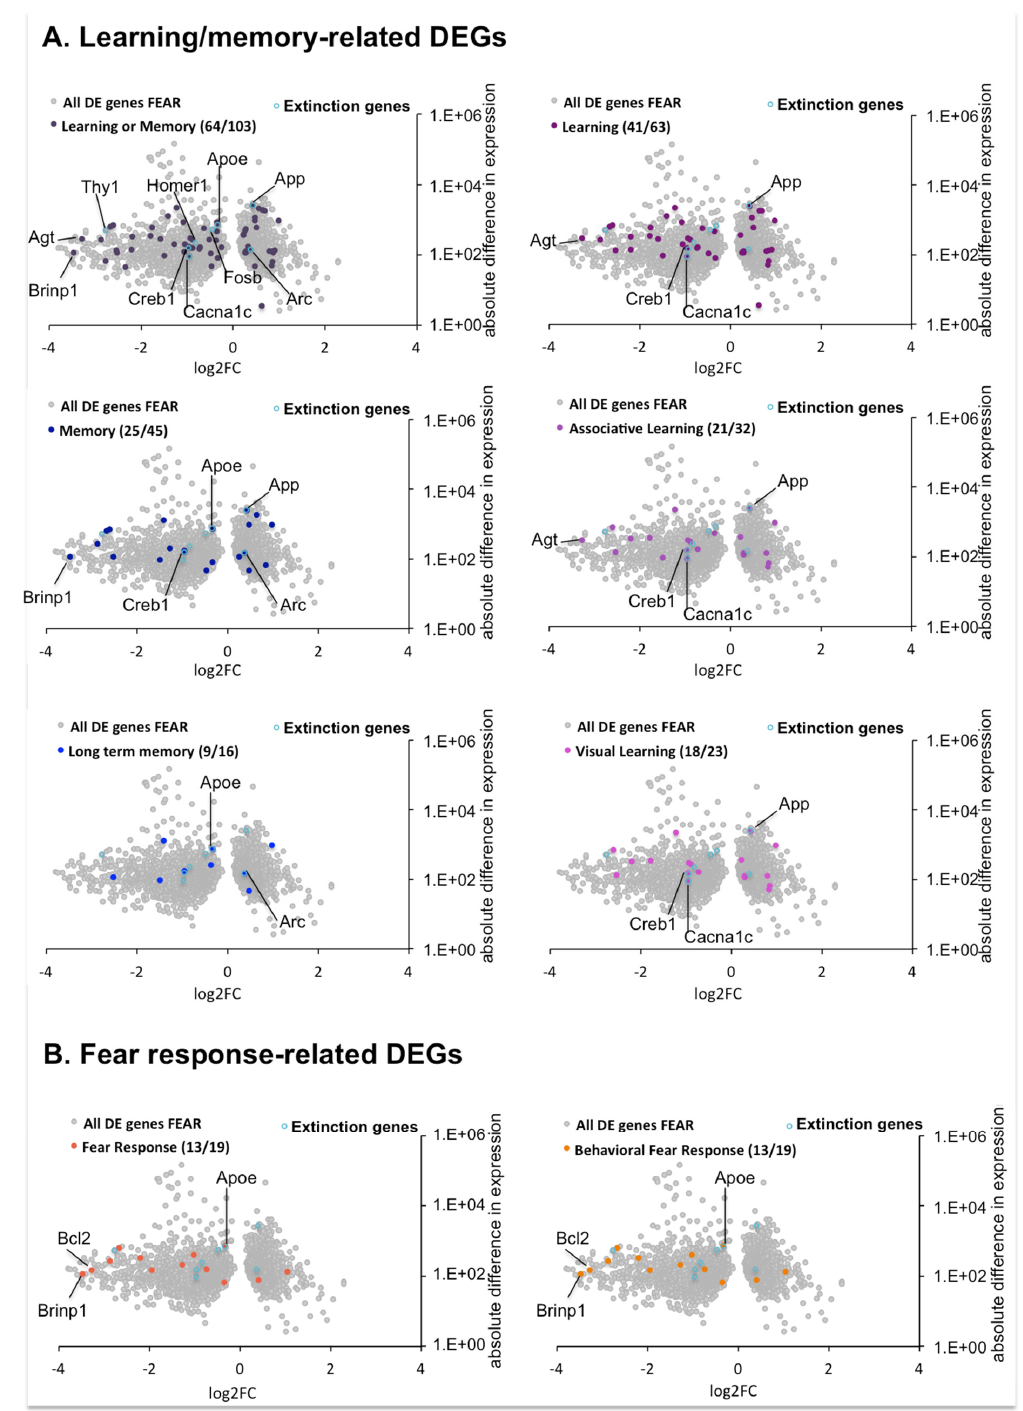
Figure 7. Differentially Expressed Genes (DEGs) with Gene Ontology annotations associated to Learning/memory and Fear response, between OPTO FEAR vs. SHAM FEAR groups. DEGs for each indicated Biological Process (BP) are highlighted as colored dots on the volcano plot representing the total DEGs between OPTO FEAR vs. SHAM FEAR groups, indicated by grey dots. Numbers into brackets indicate the number of DEGs related to each indicated BP over the gene universe. Light blue dots indicate genes described in literature as associated to fear extinction. When DEGs are part of the top twenty DEGs list and/or part of the considered BP the gene name is